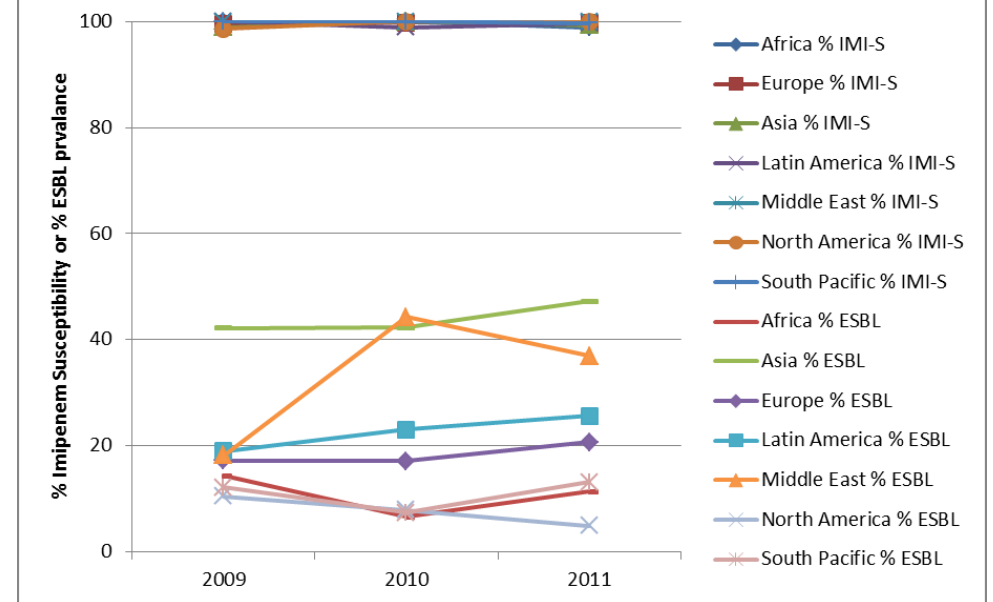
Figure 6. Susceptibility of E. coli from urinary-tract infections to imipenem (IMI-S) and prevalence of ESBLs by region from SMART 2009 to